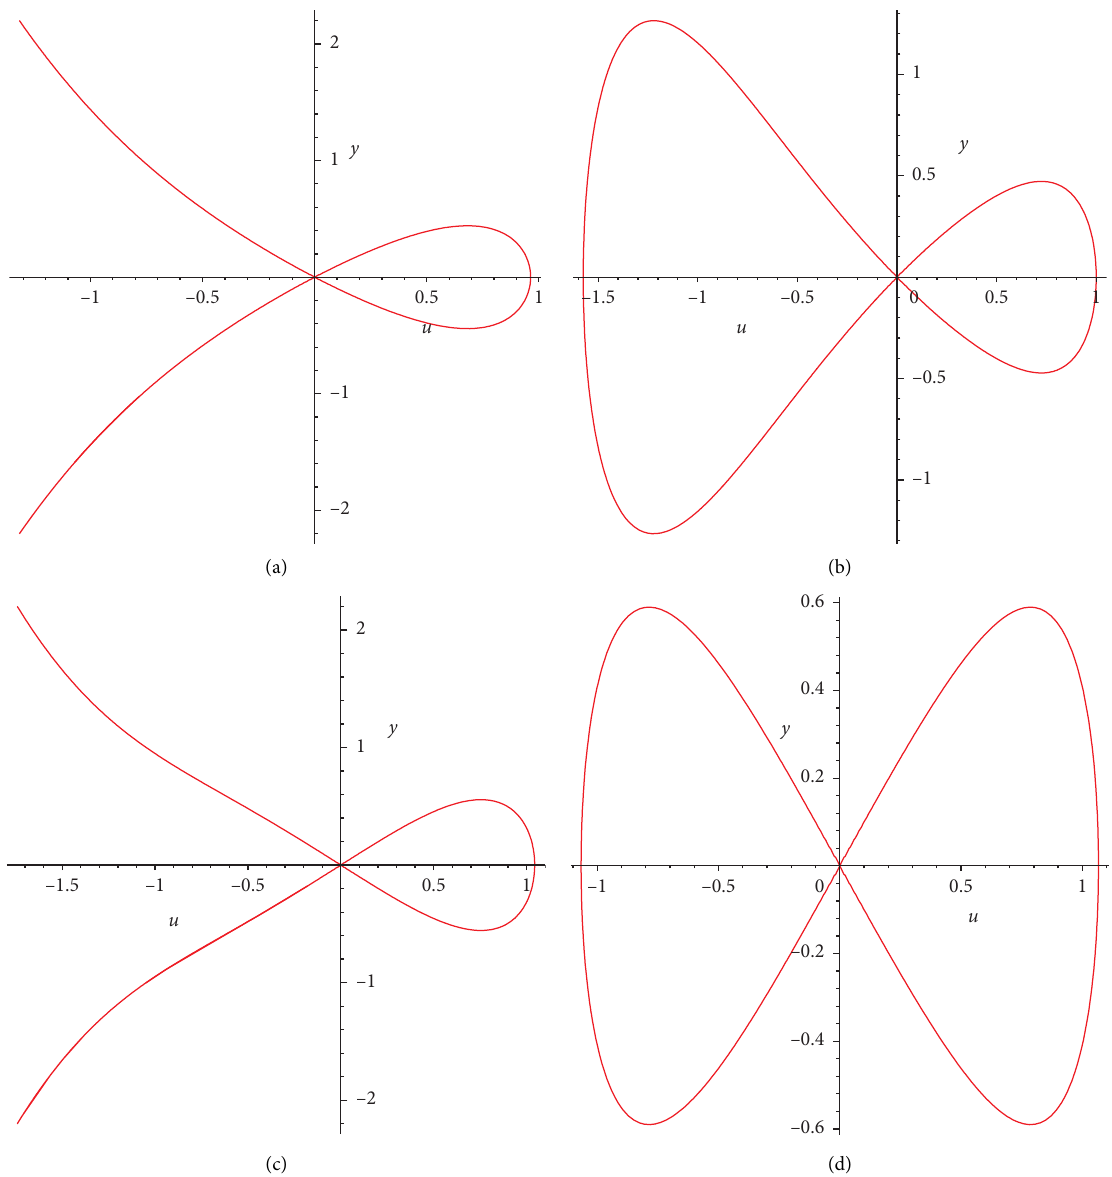
Figure 1: The level set of H ( u, v ) . (a) ( p, q ) � ( 1 , 3 ) . (b) ( p,q ) � ( 1 , 4 ) . (c) ( p,q ) � ( 2 , 3 ) . (d) ( p,q ) � ( 2 , 4 )